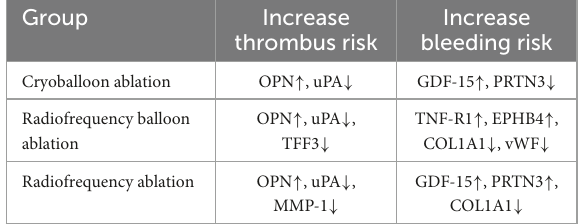
TABLE 6 Protein changes are associated with hemorrhage and coagulation activity. Group